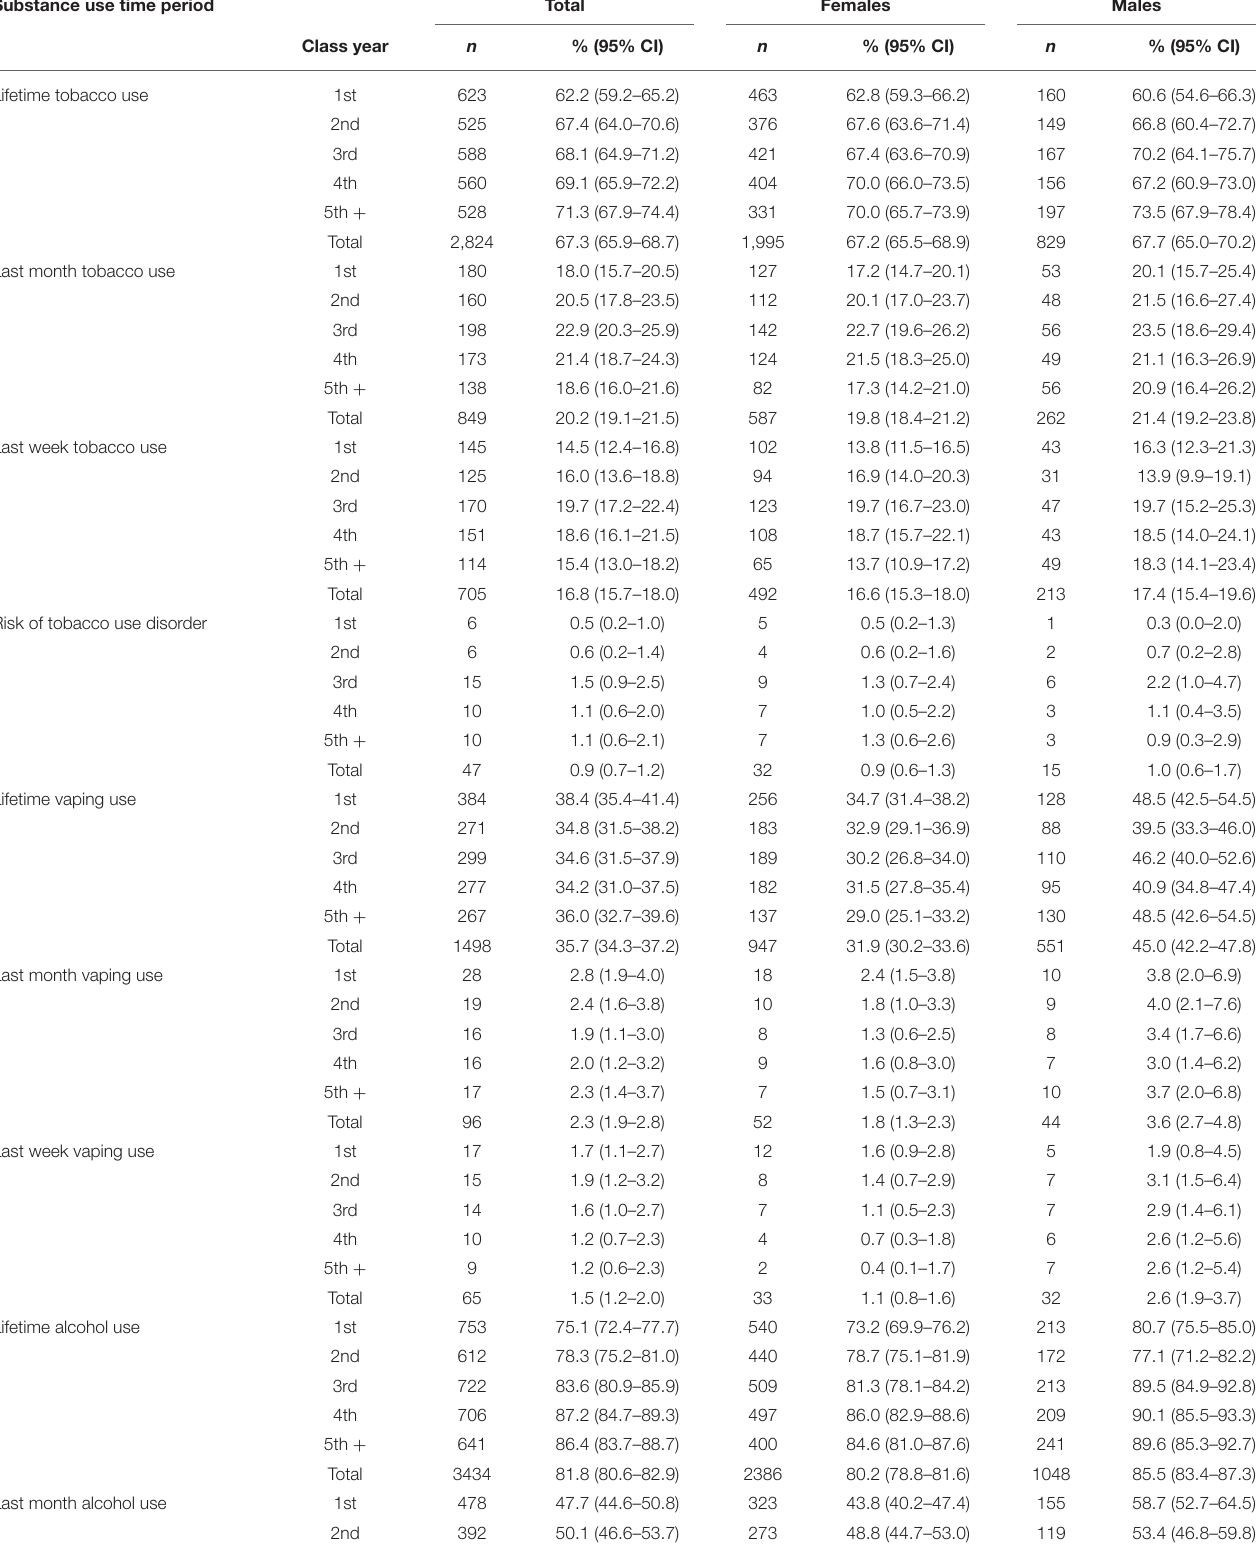
TABLE 2 | Substance use